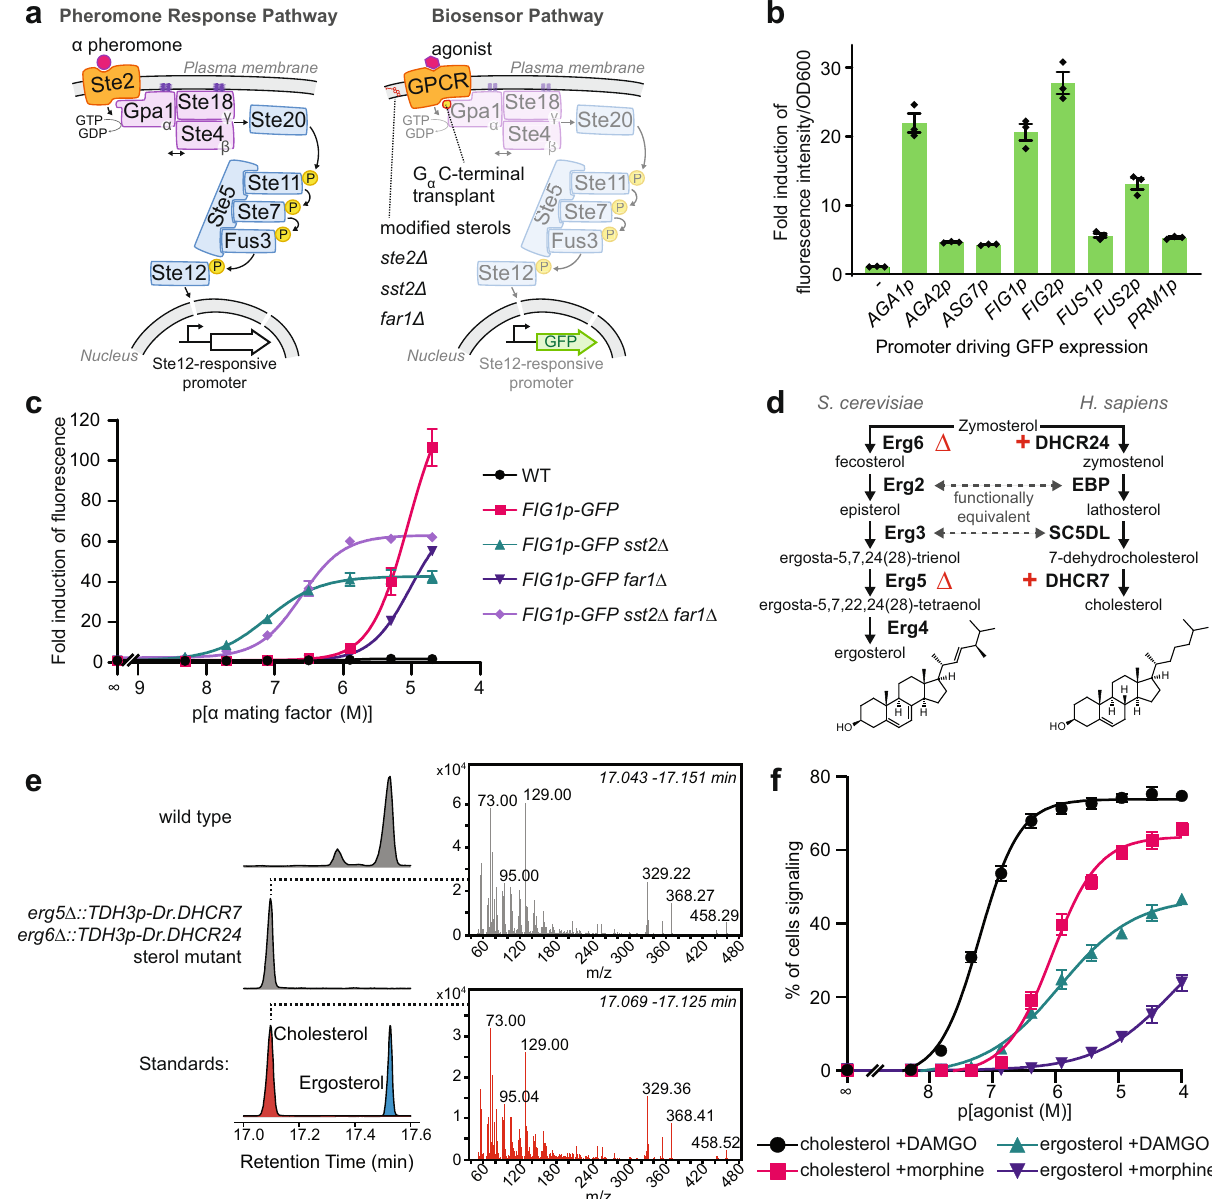
Fig. 1 Development of a yeast-based opioid biosensor. a Strategy to adapt the yeast pheromone response pathway (PRP, left) into a biosensor pathway (right). An exogenous GPCR is introduced and linked to the pathway by a Gpa1 chimera. Deletion of STE2 , SST2 , and FAR1 respectively prevents interference, potentiates signaling, and blocks signaling-induced cell cycle arrest. Ergosterol is replaced by cholesterol and a promoter controlled by the PRP-responsive Ste12 transcription factor drives GFP expression. b Biosensor reporter promoters tested using alpha mating factor-induced GFP expression from yeast Ste12-responsive promoters measured on a plate reader after 3 h treatment. n = 3 biologically independent experiments. c PRP sensitivity and activity resulting from SST2 and/or FAR1 deletions. Strains were treated with alpha mating factor for 6 h and mean fl uorescence was measured by fl ow cytometry. n = 3 biologically independent experiments; 10,000 cells/strain/replicate. d Ergosterol and cholesterol biosynthetic pathways from zymosterol. e GC-MS analysis of sterol extracts showing successful synthesis of cholesterol in an erg5/6 DHCR7/24 background. Chromatograms indicating retention times of derivatized sterols from a wild type strain (top), the engineered strain (middle), and standards (bottom). MS spectra extracted from engineered strain (top) and cholesterol standard (bottom). f DAMGO and morphine dose-response curves for ergosterol- and cholesterol-producing HsMOR-based biosensors. Measured by fl ow cytometry after 8 h agonist treatment. n = 3 biologically independent experiments; 10,000 cells/strain/replicate. Data presented as mean + / − SEM. Source data are provided as a Source Data fi